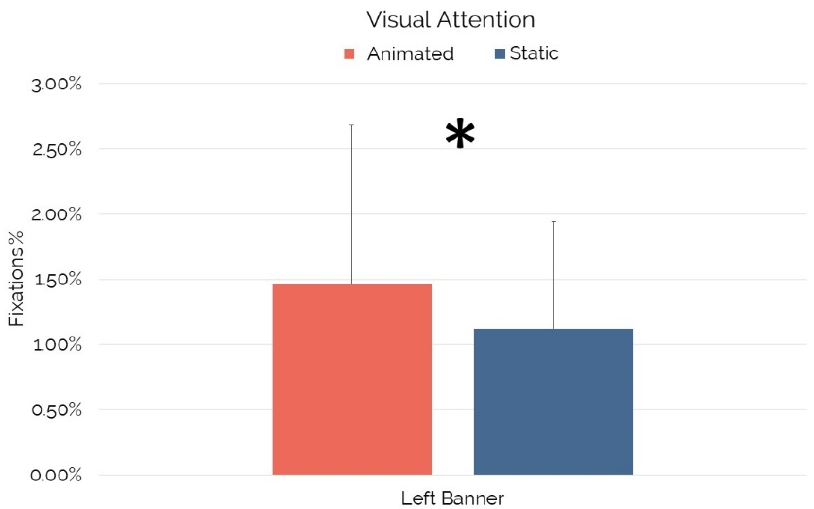
Figure 2. Visual attention for Left Banner in Animated and Static format. Error bars represent standard deviation. Asterisks indicate statistically significant differences.